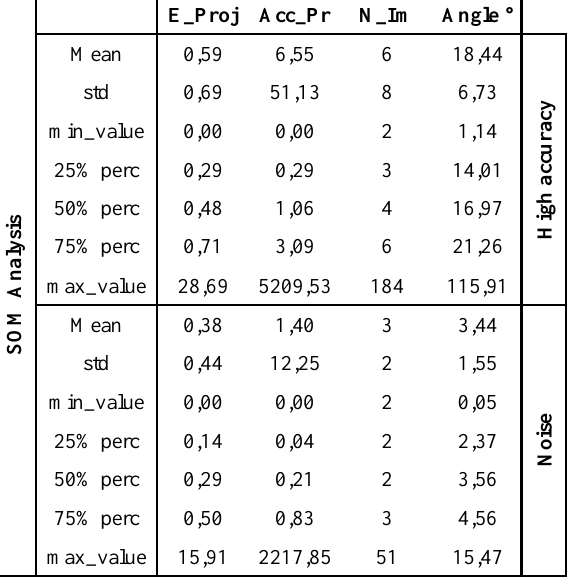
Table 1. SOM clustering: feature parameter analysis.